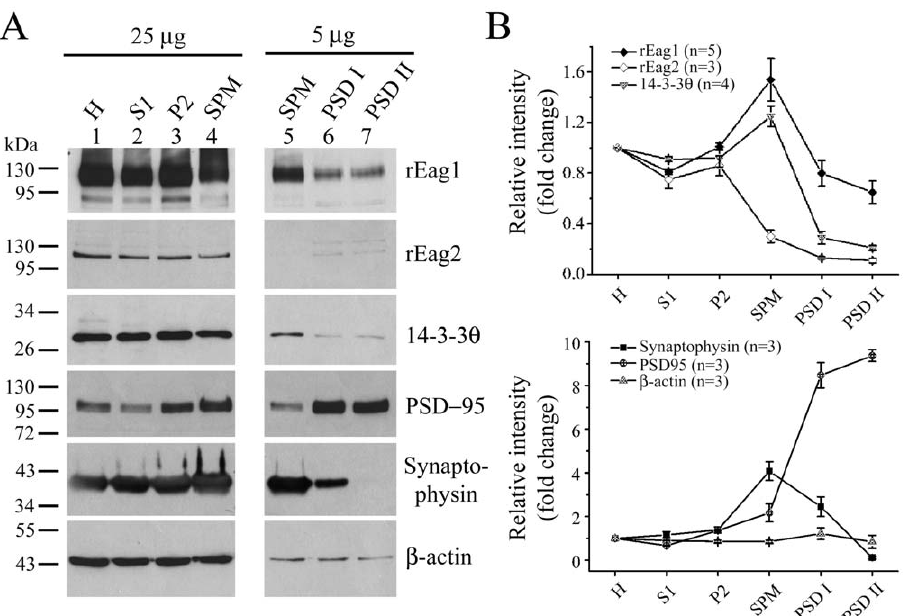
Figure 6. Localization of 14-3-3 h and rEag1 in synaptosomal and PSD fractions. ( A ) Subcellular fractionation separated rat brains into multiple fractions: homogenate (H), soluble fraction (S1), crude membrane fraction (P2), synaptosomal fraction (SPM), and two postsynaptic density (PSD) preparations (PSD I: one Triton X-100 wash; PSD II: two Triton X-100 washes), all of which were subject to immunoblotting analyses with the indicated antibodies. 25 m g and 5 m g refer to the amount of total protein loaded in each lane. ( B ) Quantitative analyses of protein abundance in different subcellular fractions. Densitometric scans of immunoblots were obtained from three to five independent experiments. Data were presented as normalized values with respect to cognate protein expression levels in the homogenate (H) fraction.